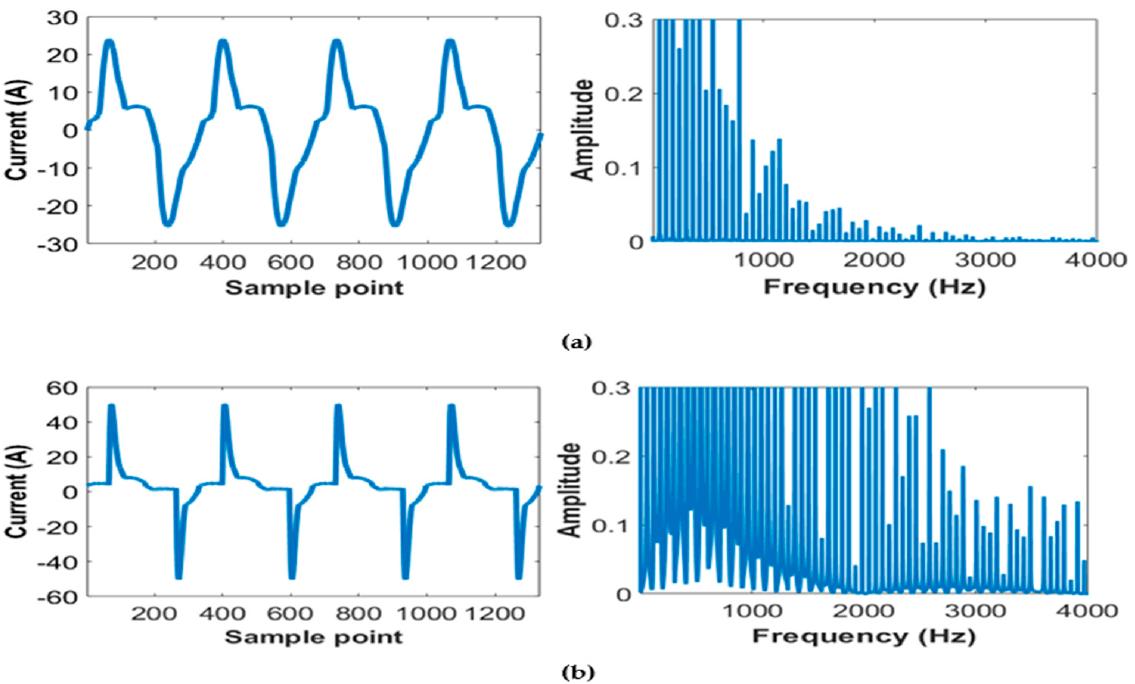
Figure 6. Measurement results for mixed loads ( a ) normal state, ( b ) arc fault state. The load of a 500 W vacuum cleaner is measured in Figure 5. The current waveform in normal state closes to a triangle shape with apparent characteristic harmonics, as shown in Figure 5a. At arc fault state, the current waveform shows temporal interruption at